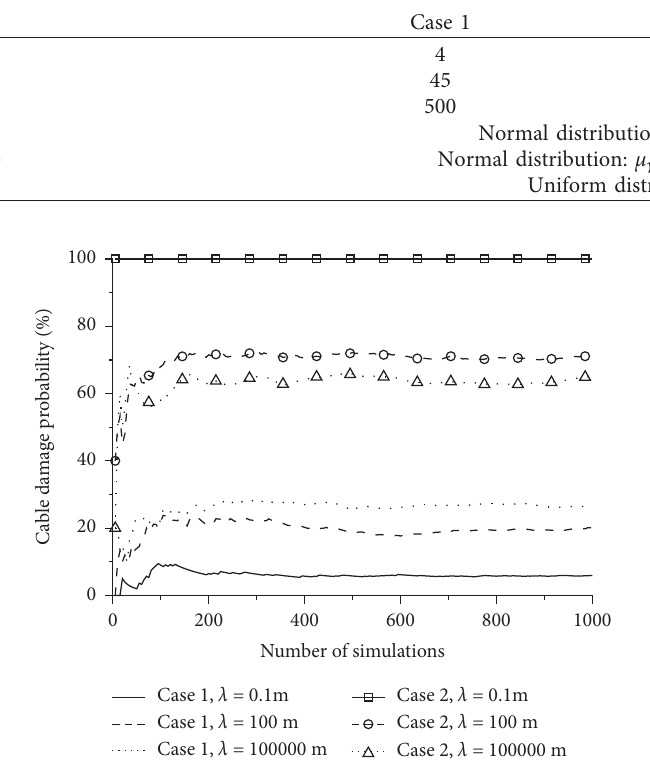
Figure 11: Influence of the number of MCS for Case 1 and Case 2 with different λ